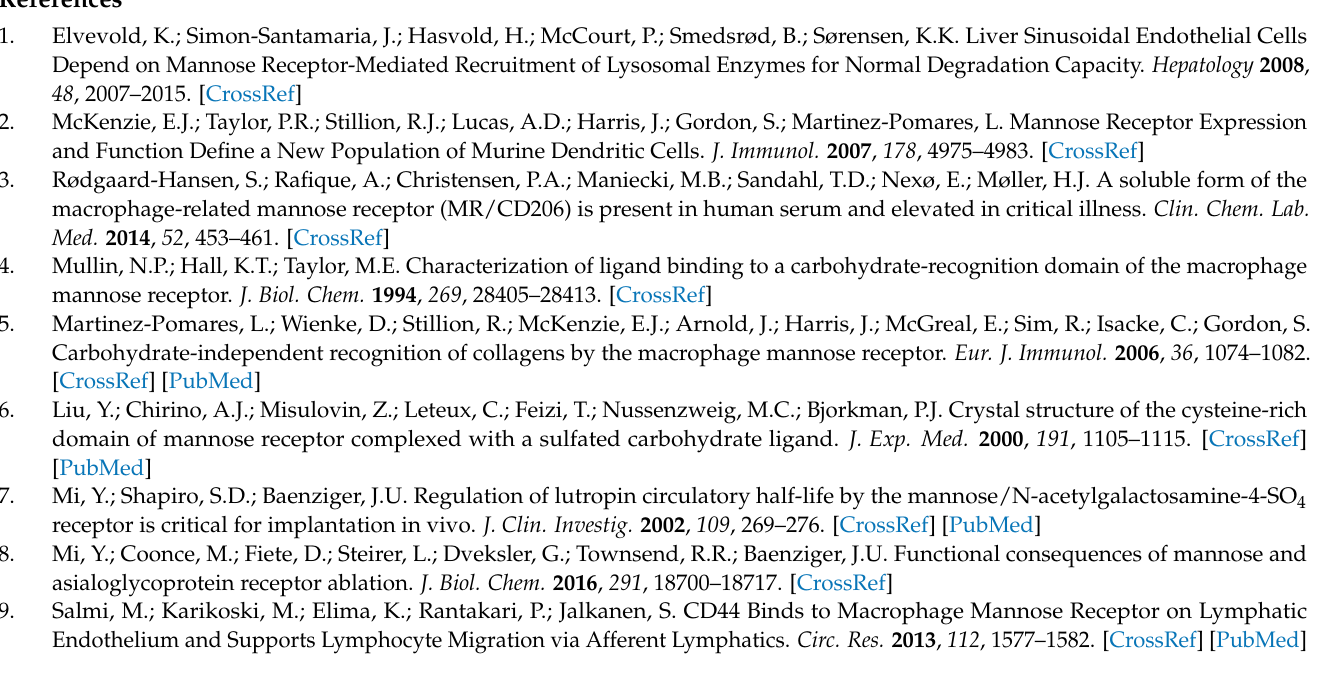
Figure S3: Gating strategy for bone marrow immunophenotyping [37]; Figure S4: Visceral adipose tissue flow cytometry gating strategy for immunophenotyping of WT and Mrc1 − / − mice with diet- induced obesity; Figure S5: Liver flow cytometry gating strategy and liver immune characterization of WT and Mrc1 − / − mice fed with HFD; Figure S6: Impact of Mrc1 deficiency on the metabolic phenotype in mice with diet-induced obesity; Table S1: Antibodies used for flow cytometry analyses; Table S2: Primer sequences used for real time qPCR on BAT